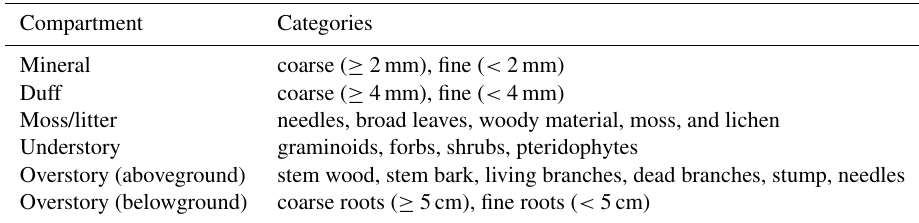
Table 1. CCV categories for ecosystem compartments given in dry weight (kg).